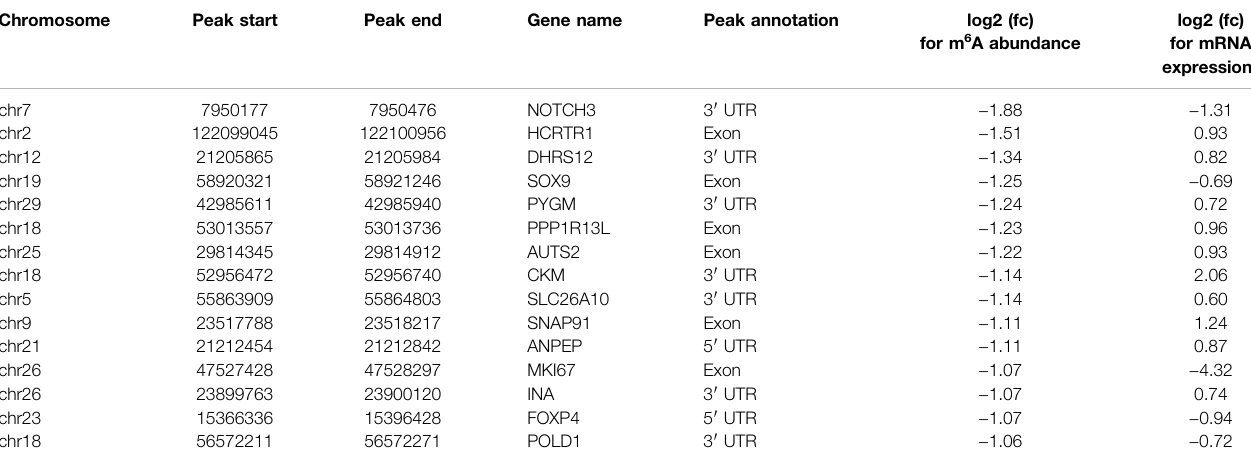
TABLE 4 | Top 15 down-regulated m 6 A methylated genes between DMGs and DEGs.